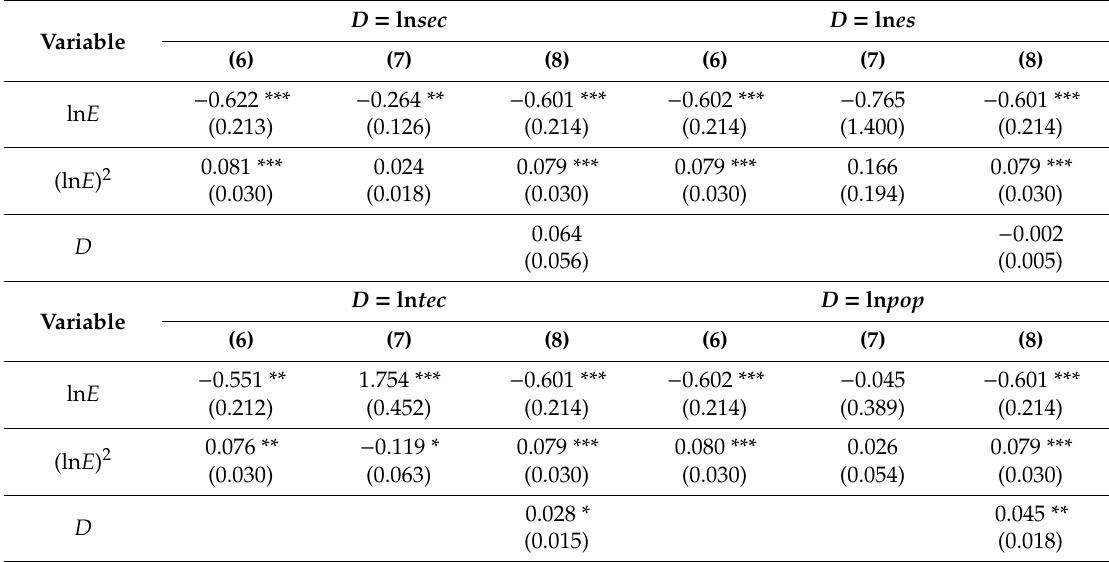
Table 10. Non-pilot city intermediary e ff ect